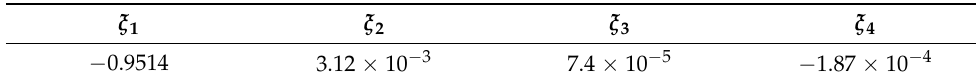
Table 1. Empirical parameters of activation